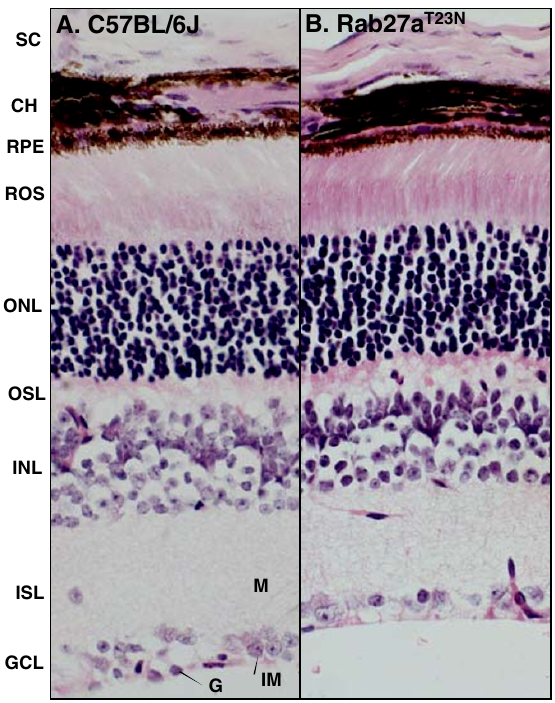
Figure 10 Histochemical staining of Rab27a T23N transgenic mouse ret- ina. Transverse paraffin sections (3 µ m) from 10 month-old C57BL/6J ( A ) or Rab27a T23N transgenic mouse (line A27aT25/2) ( B ) are shown. Magnification is approximately × 250. The abbreviations used are: sclera (SC), choroid (CH), retinal pigment epithelium (RPE), photoreceptor segments of rods and cones (ROS), nuclei of rods and cones (ONL), outer synaptic layer (OSL), neuron nuclear layer (INL), inner synaptic layer (ISL), ganglion cell layer (GCL), slender glial (Muller) cell processes (M), ganglion cells (G) and inner limit- ing membrane